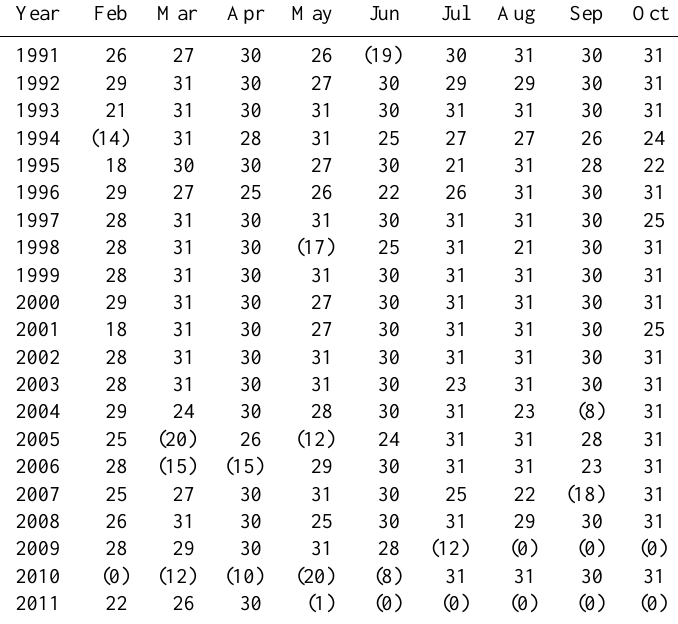
Table 1. Number of days used for the calculation of the monthly average. Months with more than 10 missing days were not used in the trend analysis and are shown in